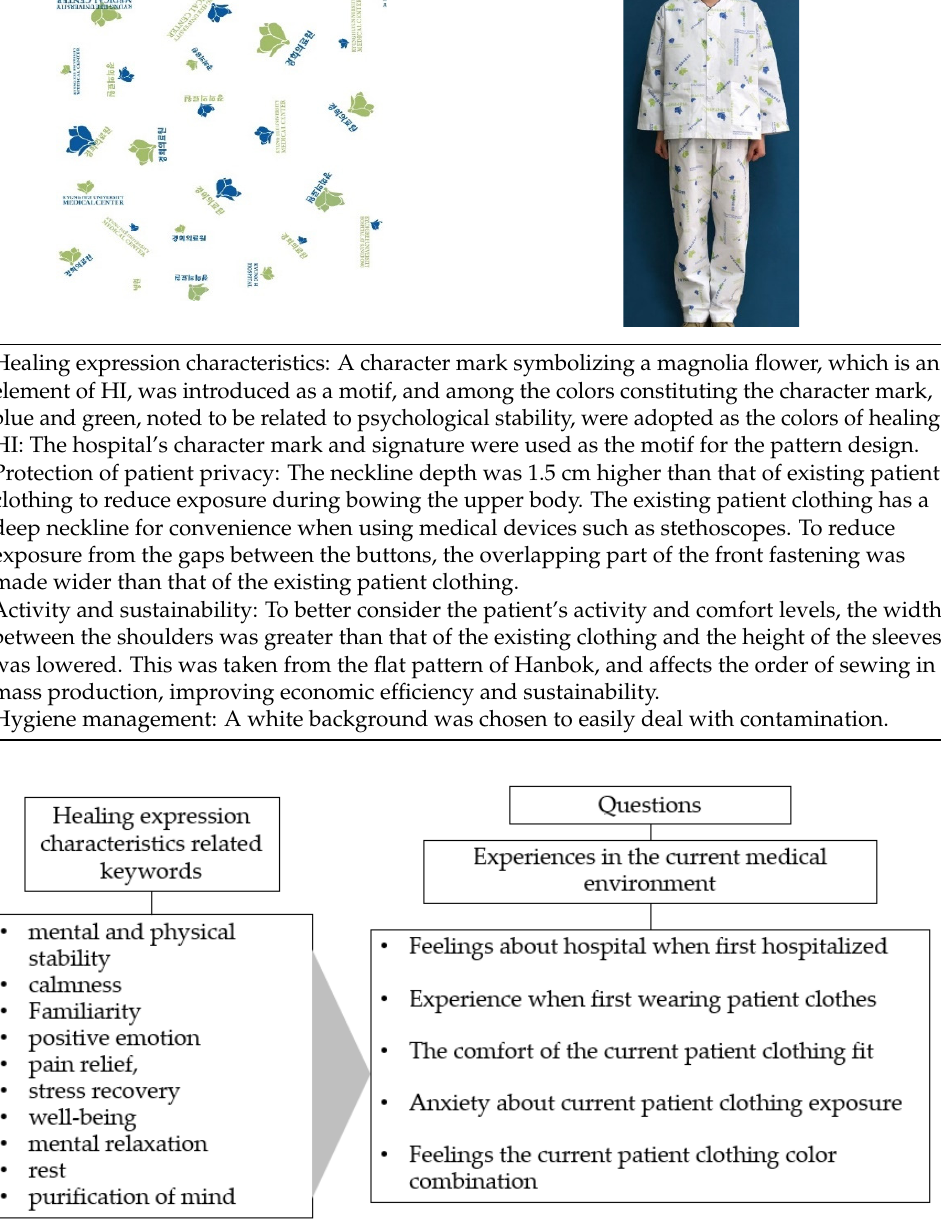
Figure 4. Questions used to elicit patients’ feeling about the current medical environment